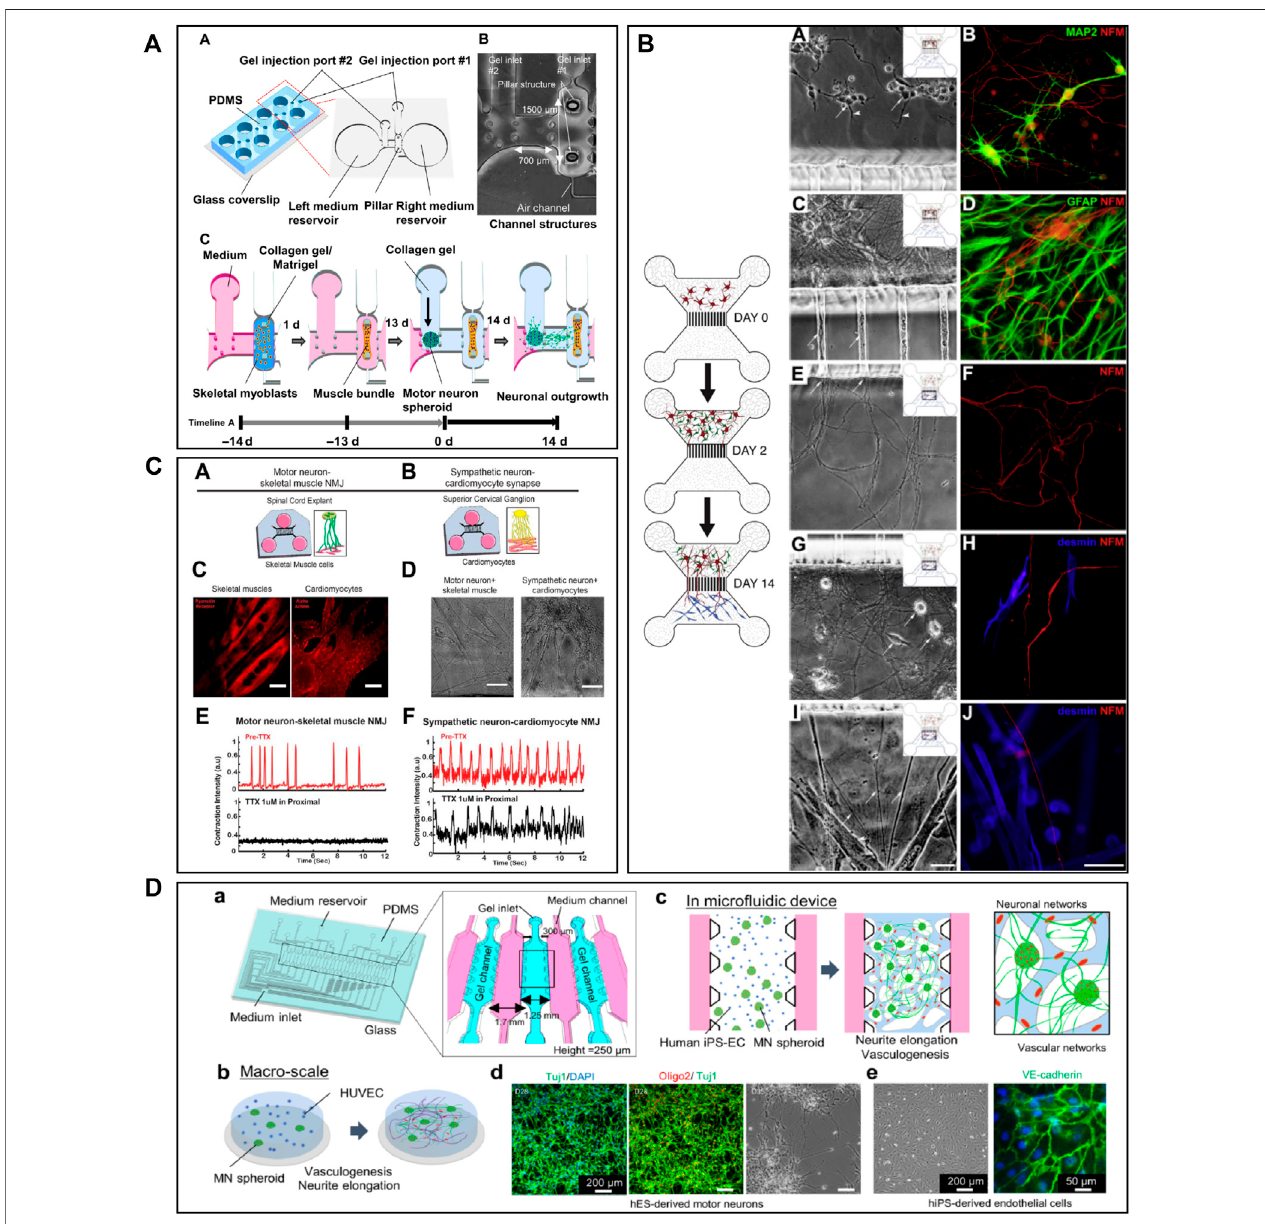
FIGURE 1 | Micro fl uidic devices used in Alzheimer ’ s disease modelling. (A) Generation of a co-culture of neurons with disease induction using 3 nodes compartmentalized chip with reservoirs to study molecular schematization of inhibitor effect of okadaic acid (OA) on dephosphorylation of Tau-microtubule-binding. ExtractedfromKunzeetal.(2011)(copyrightWilleyPeriodicals). (B) Designofmultinodescompartmentalizedmicro fl uidicdeviceandimmuno fl uorescencepictures( β III- tubulin (red) for axonal and MAP2 (green) for somatodendritic staining, Hoechst (blue) for cell bodies, Synaptophysin 1 (yellow) for presynaptic, Homer 1 (cyan) for postsynaptic sainting, MAP2 (magenta) for dendrites) of presynaptic (pre), postsynaptic (post) and synaptic chamber as well as co-culture chamber with non-neural cell types. Extracted from Kilinc et al. (2019) (copyright Oxford University Press — Brain). (C) 3D micro fl uidic platform with AD neurons, astrocytes h-NPCs-derived and human adult microglia in culture for organotypic human AD modelling. The platform quanti fi es microglial engagement using immuno fl uorescent pictures [AD neurons/ astrocytes (green), microglial cells (red) and nuclear staining (white)]. Scale bars of picture d and e represent 250 µm. Scale bars for picture f and g represent 150 µm. Extracted from Park et al. (2018), (copyright Nature